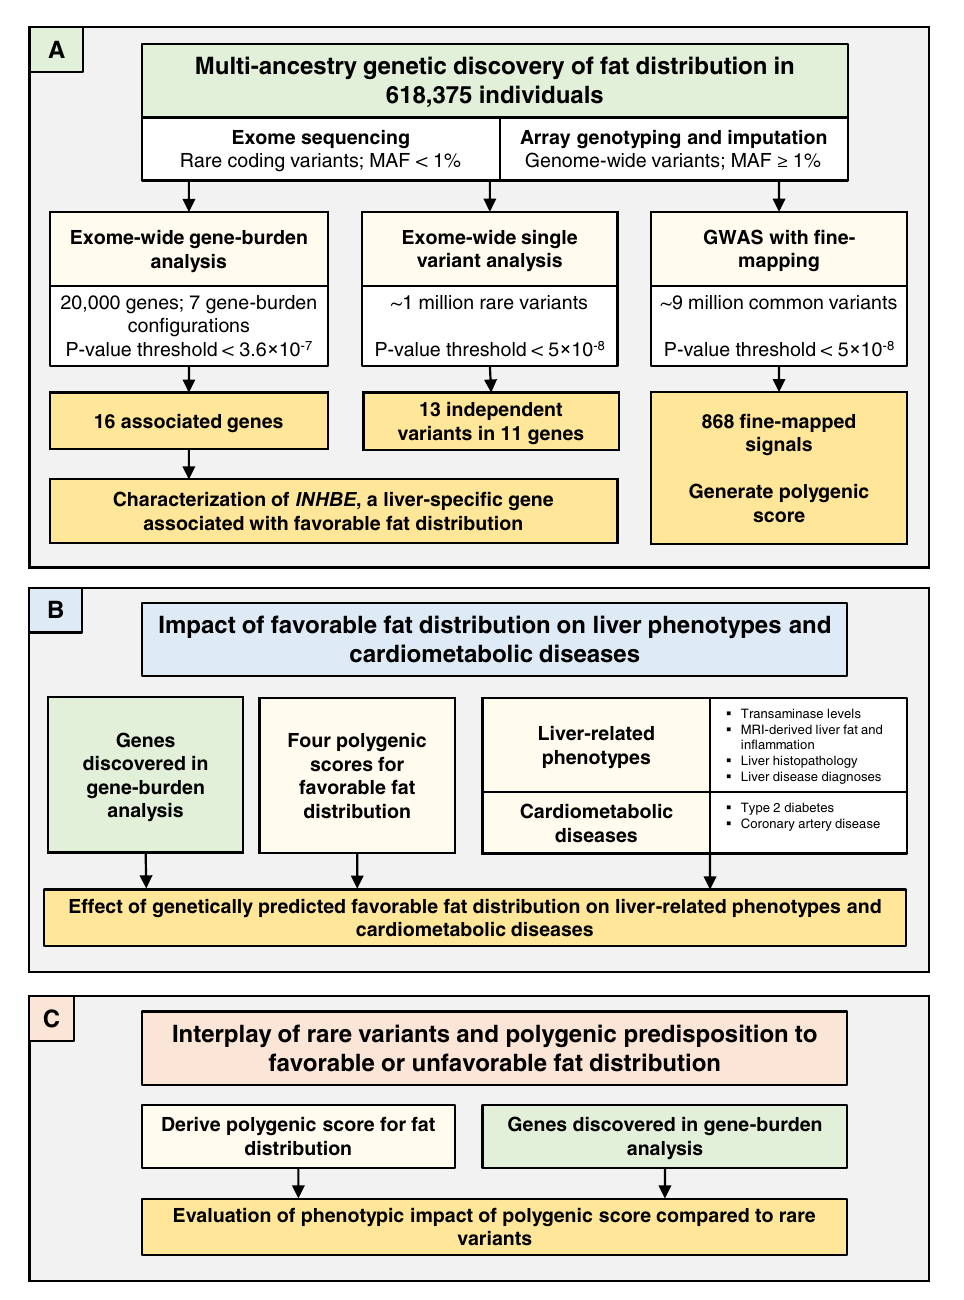
Fig. 1 | Study overview. We performedthree majorgroups of analyses, illustrated in ( A – C ). A outlines the multi-ancestrygeneticdiscoveryanalysis forBMI-adjusted WHR. B summarizes association analyses for genetically determined fat distribu- tion, liver health parameters and cardiometabolic disease. C outlines the